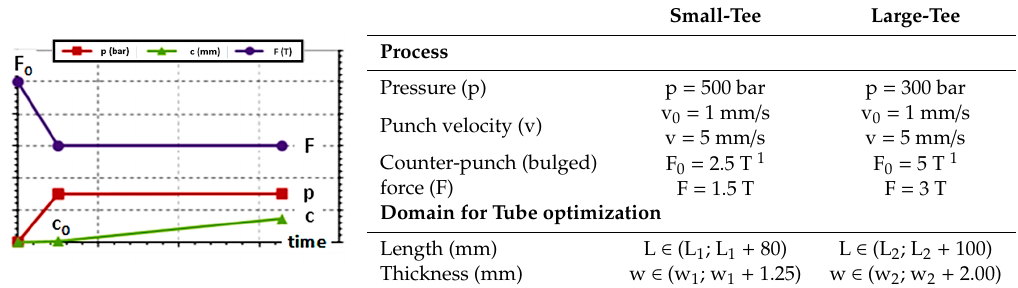
Figure 4. Small-Tee. Thinning at different instants of the hydroforming process. ( a ) initial deformation phase; ( b ) final deformation phase.